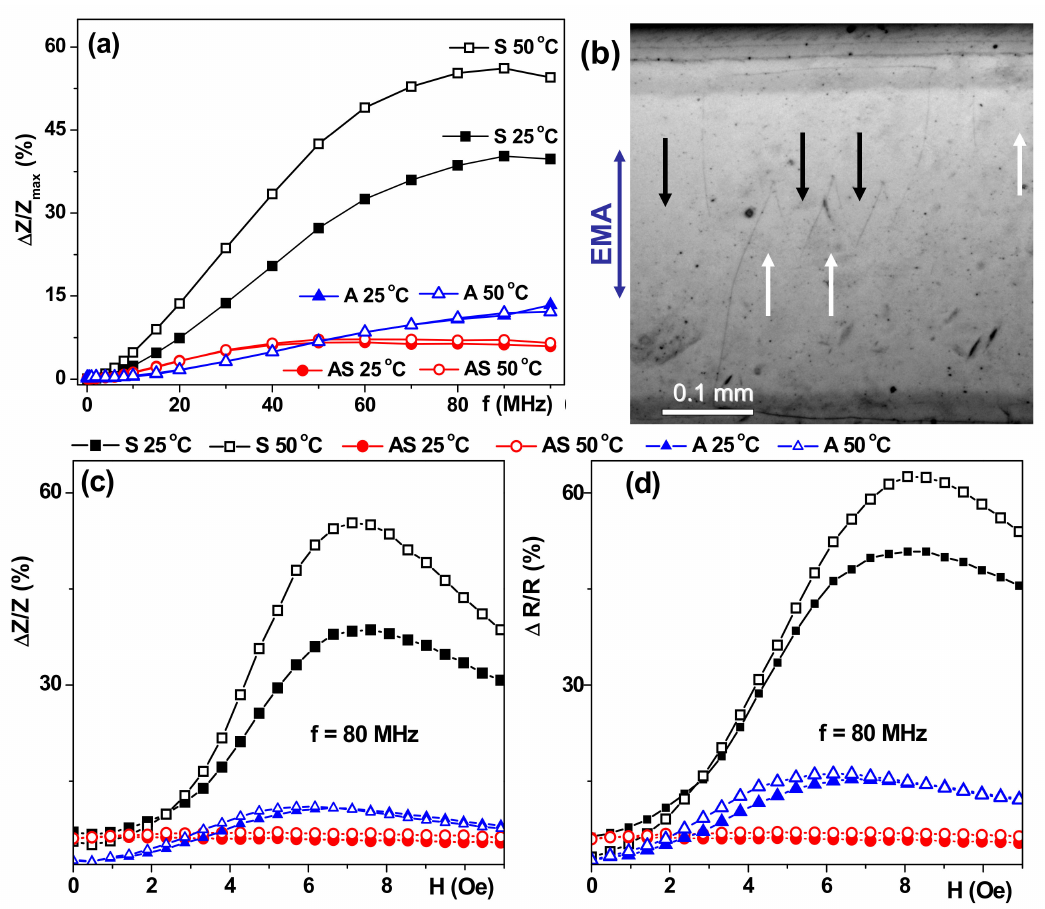
Figure 6. Frequency dependence of the maximum value of the ∆ Z/Z ratio for low and high temperatures for S − G/[Cu(3 nm)/FeNi (100 nm)] 5 /Cu(500 nm)/[Cu(3 nm)/FeNi(100 nm)] 5 , AS − CO/[Cu(3 nm)/FeNi(100 nm)] 5 /Cu (500 nm)/[Cu(3 nm)/FeNi(100 nm)] 3 , and A − G/ FeNi(100 nm)]5/Cu(3 nm) multilayered structures ( a ). Magnetic domains revealed by the Akulov-Bitter technique with a ferrofluid at room temperature (25 ◦ C) in the AS sample: black and white arrows indicate the orientation of the magnetization in the domains, the easy magnetization axis (EMA) is oriented in the same direction as the direction of the applied field during thin film deposition, being parallel to the short side of the elongated stripe ( b ). The field dependence of ∆ Z/Z ( c ) and ∆ R/R ratios ( d ) for two selected